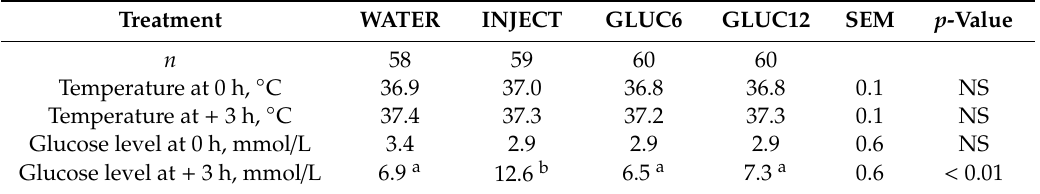
Table 1. The e ff ect of treatment * on rectal temperature and whole blood glucose level. Results are presented as lsmeans ± pooled SEM.